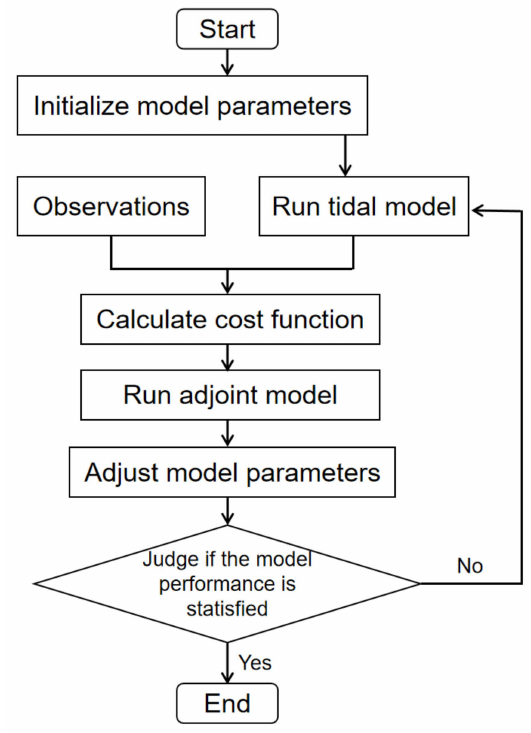
Figure 7. The flowchart for the adjoint tidal